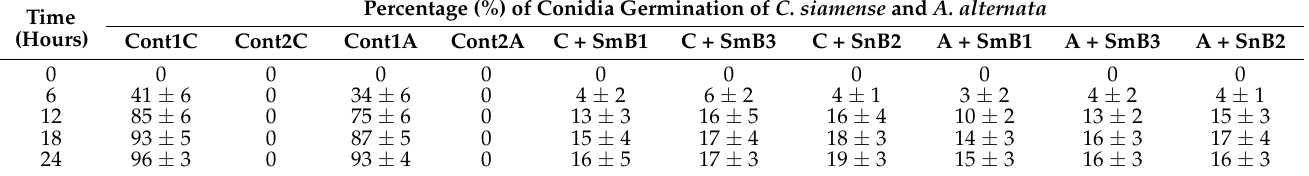
Table 1. Antifungal effect of Serratia marcescens B1 and B3 and S. nematodiphila B2 strains against conidia germination of C. siamense and A. alternata